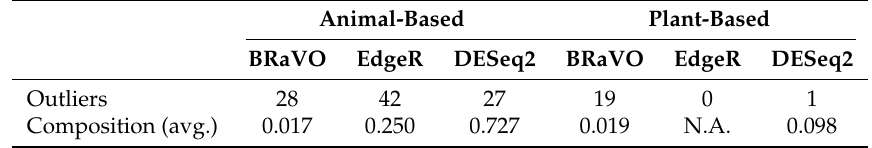
Table 1. Comparison of outliers detected by three methods. This table shows a summary of outliers detected by BRaVO, EdgeR, and DESeq2. Composition means the compositional percentages of outliers detected by each method. Outliers indicate the number of features with compositional changes in their taxonomic abundance. Animal-Based Plant-Based BRaVO EdgeR DESeq2 BRaVO EdgeR DESeq2 Outliers Composition (avg.)